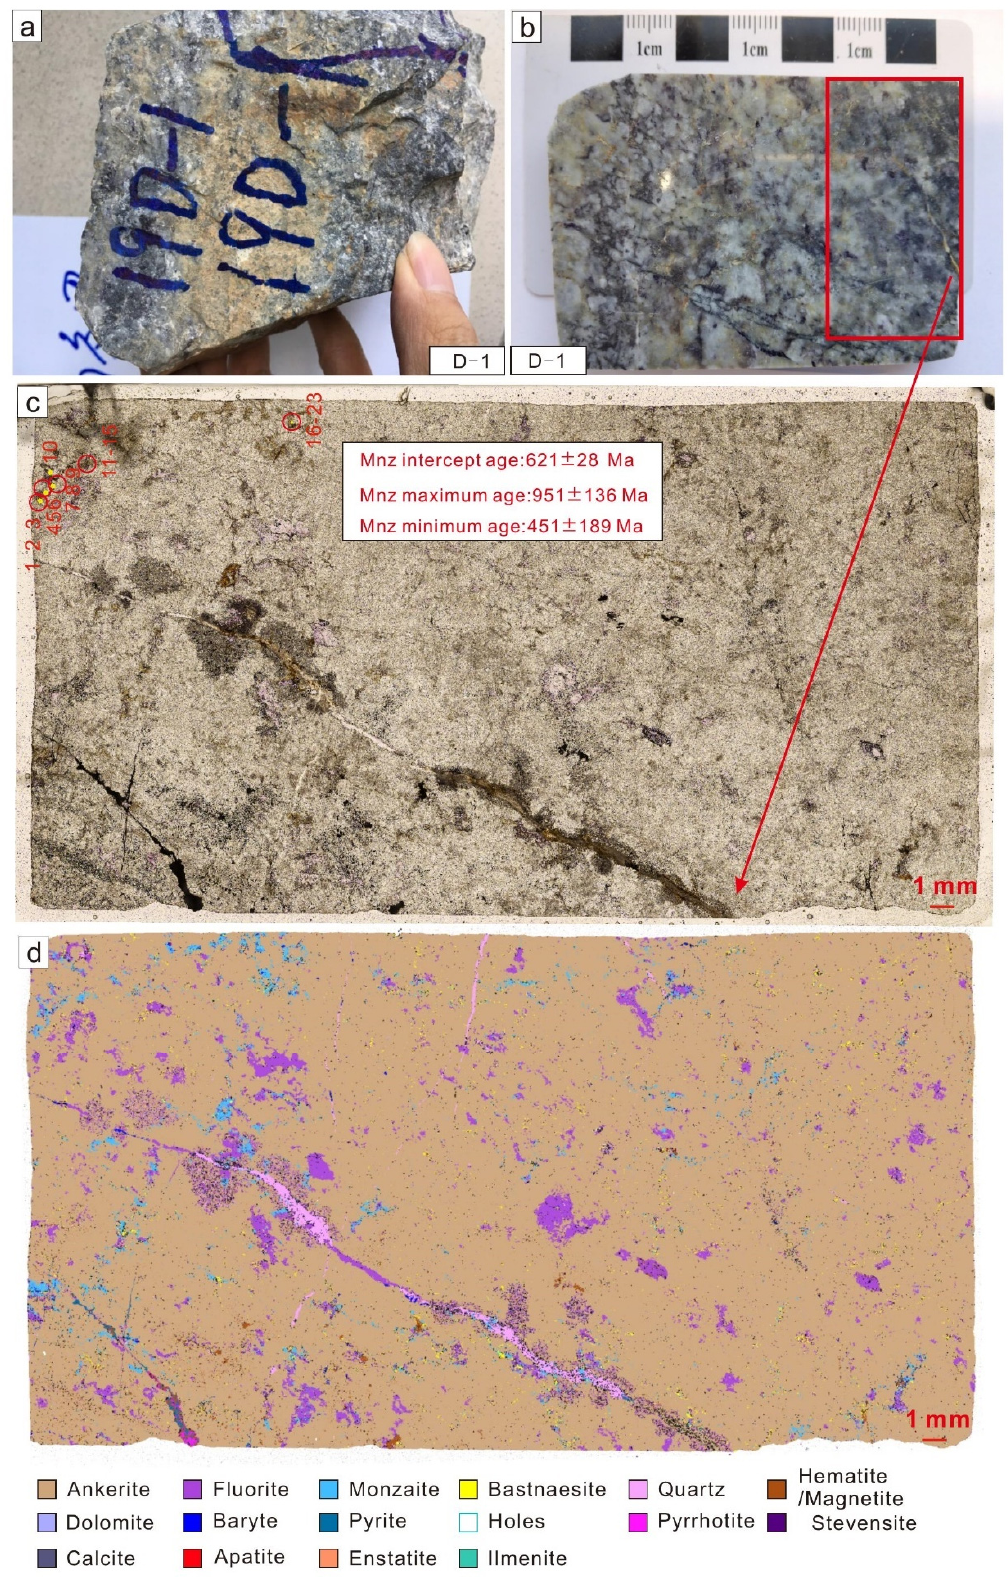
Figure 2. The petrological characteristics of sample D-1. ( a ) Hand specimen; ( b ) photograph of the polished surface of the sample, ( c ) panoramic photomicrograph under transmitted light; ( d ) TIMA mineral maps. The red box in ( b ) is the location of the thin section of ( c ).